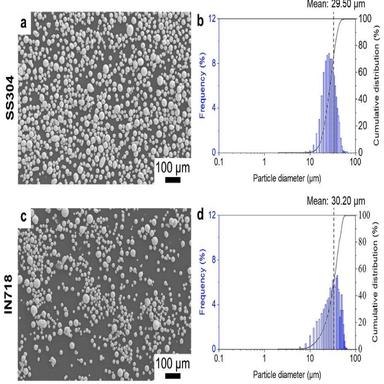
Morphology of SS304 (a) and IN718 (c) powders observed by SEM and the corresponding powder size distribution for SS304 (b) and IN718 (d) powders.